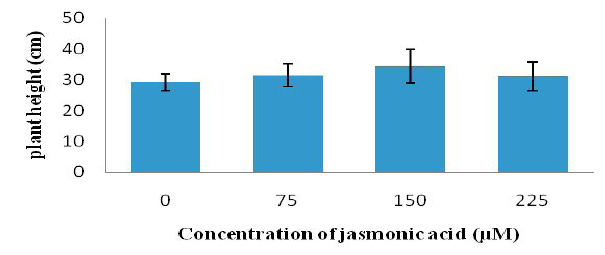
Fig. 4. Effect of different concentration of jasmonic acid on plant height